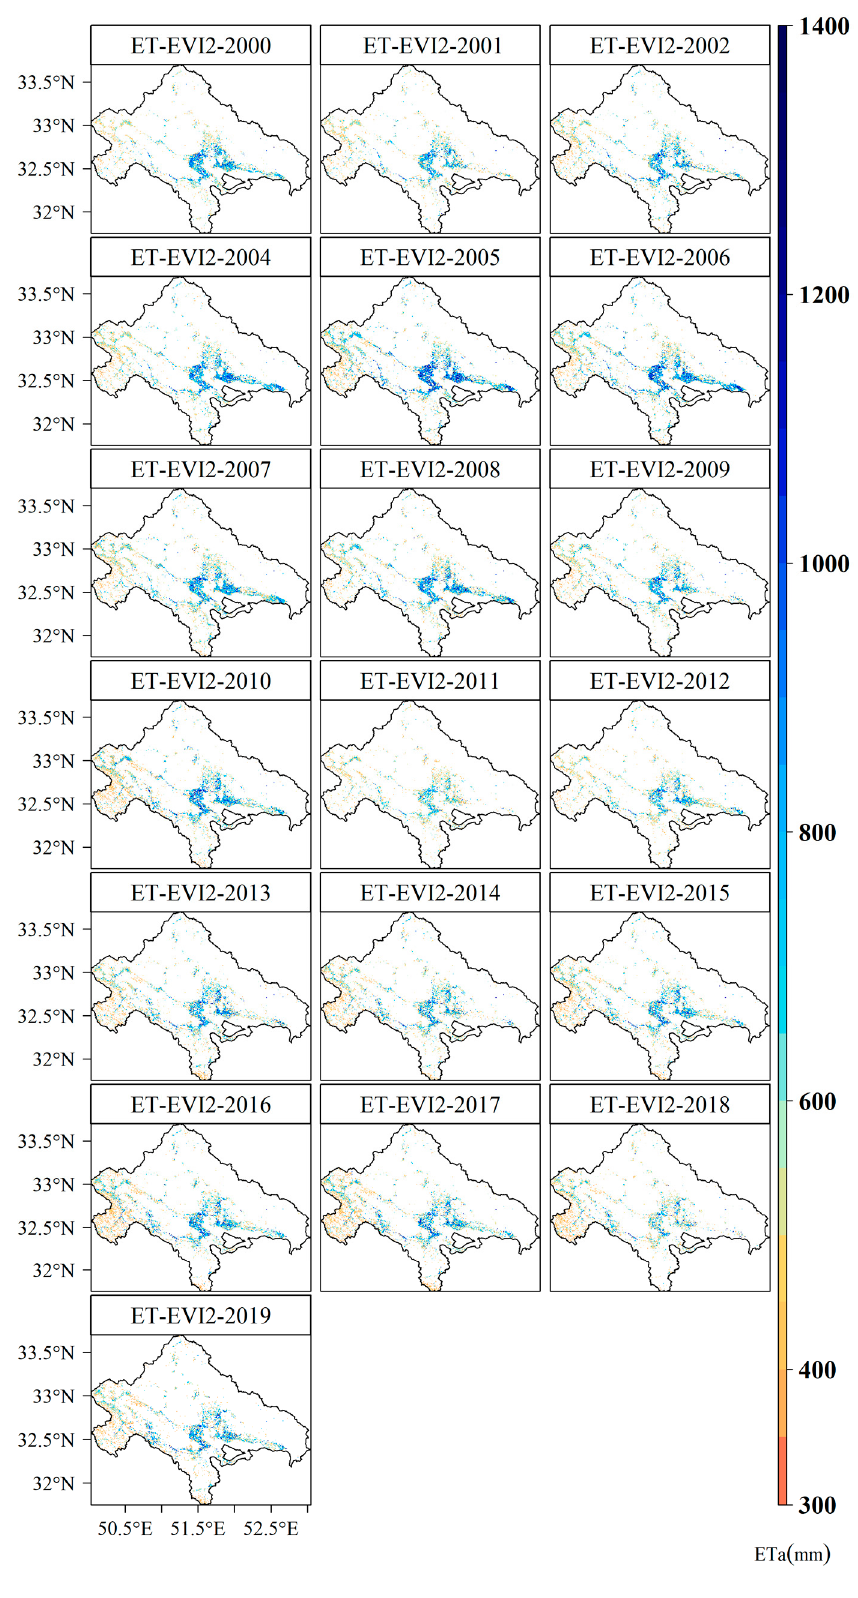
Figure A5. Annual maps of ET-EVI2.